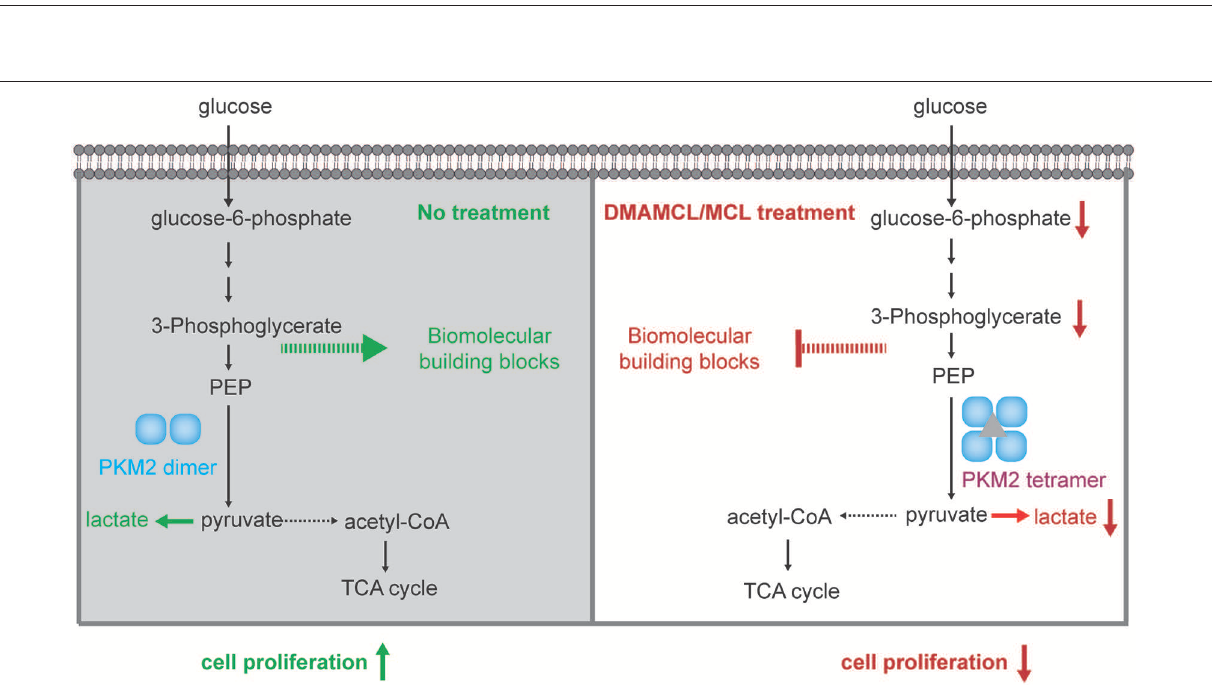
Frontiers in Oncology |